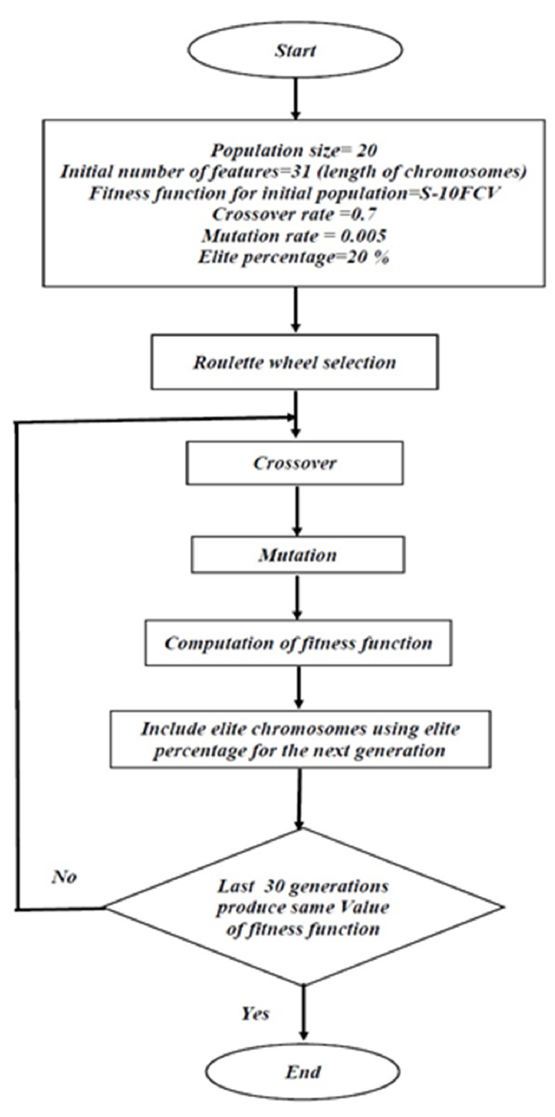
Figure 1. Flowchart of feature selection using a GA.